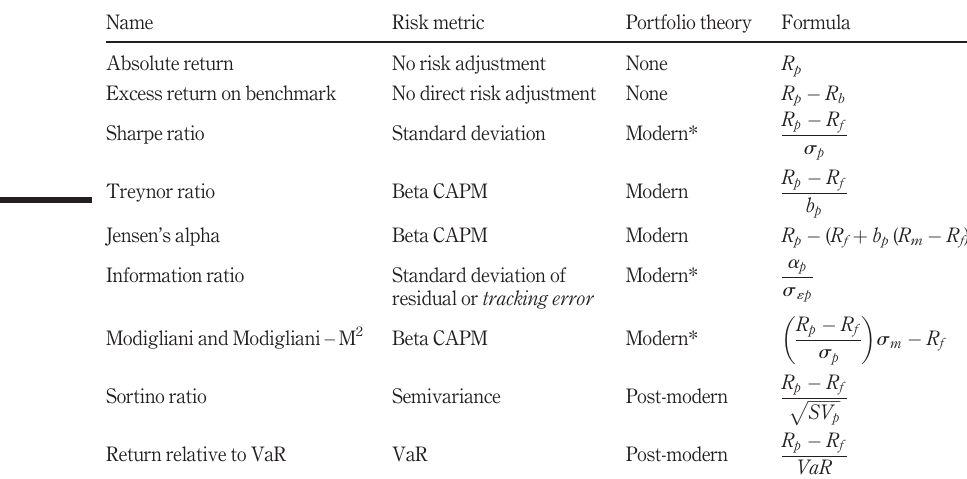
Table I. Performance